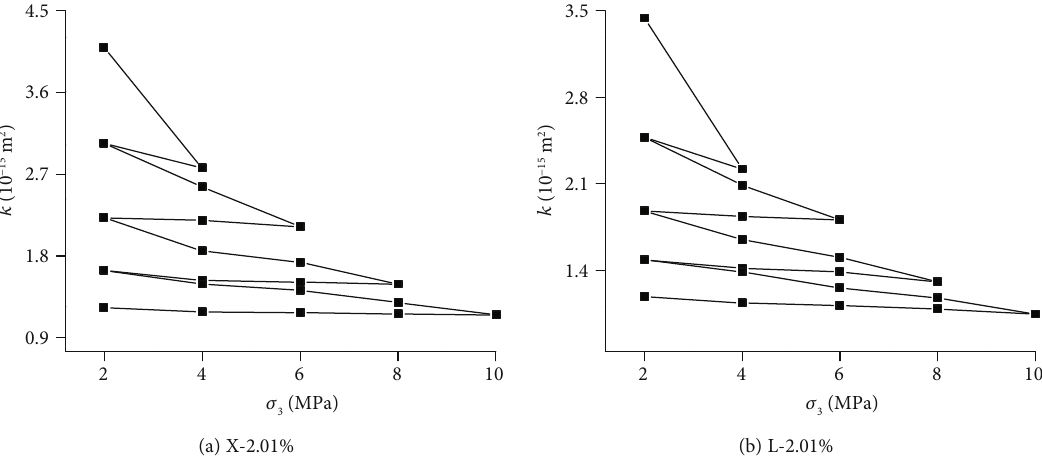
Figure 19: The permeability evolution during the loading-unloading process with the axial strain 2.01%. Table 6: The permeability evolution during the loading-unloading process with the axial strain 1.61%. Permeability